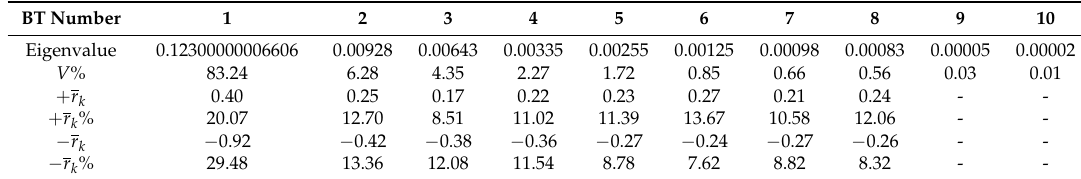
Table 3. Eigenvalues, variance percent (%V) and positive and negative correlation averages (+ r k > 0.1 and − r k < 0.1) of the forward BRMT for BT1–BT10.